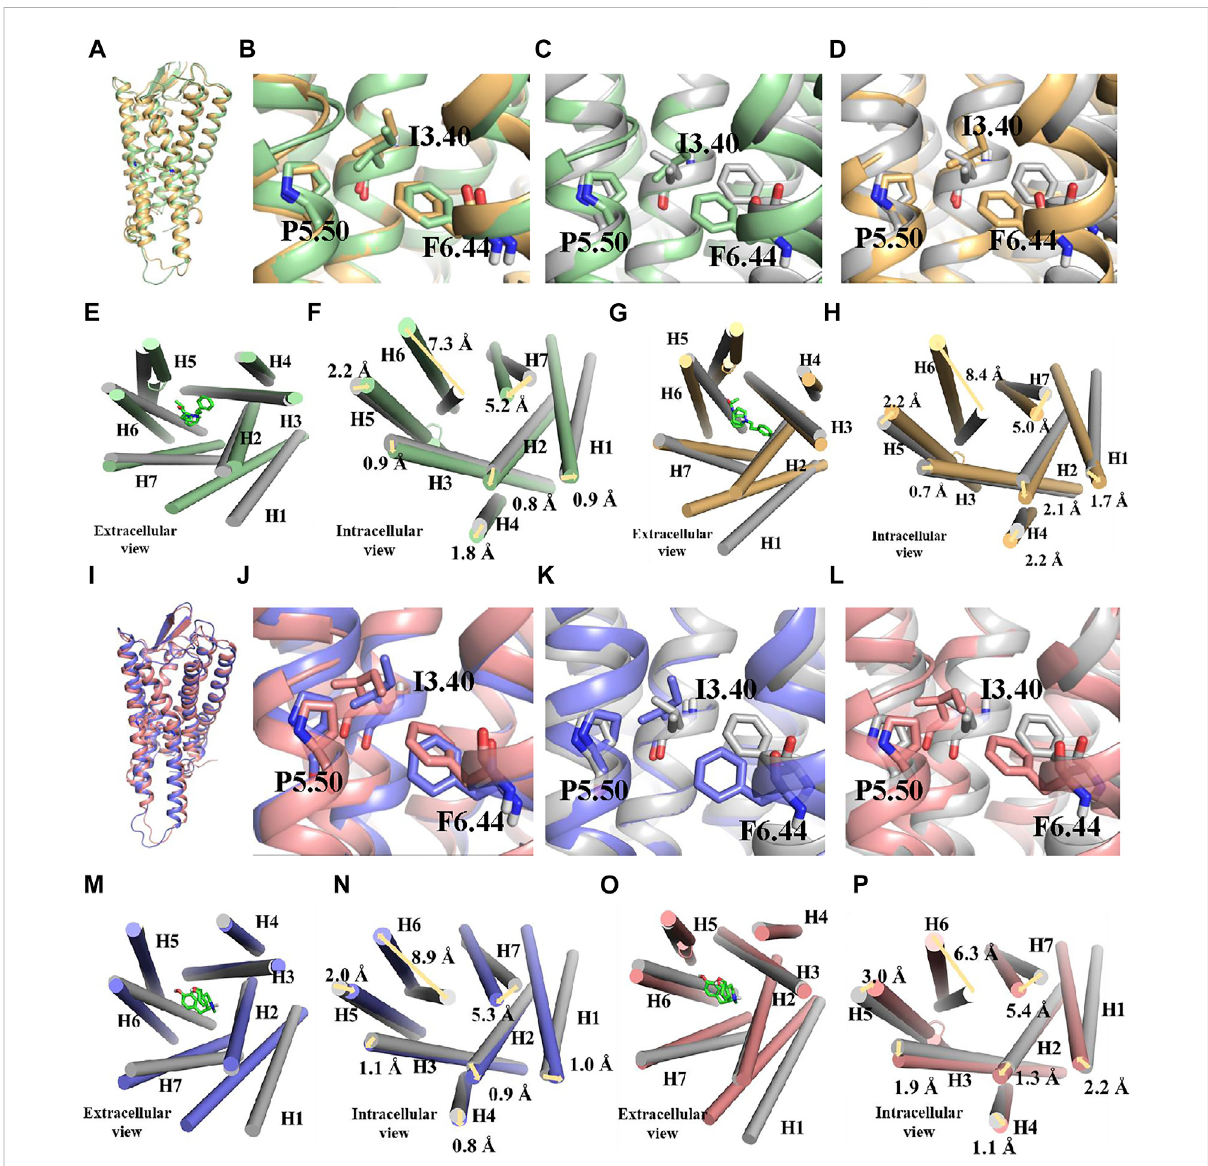
FIGURE 6 Conserved P 5.50 -I 3.40 -F 6.44 triad rearrangement and transmembrane helix change during simulations. (A – H) binding poses and changes of transmembrane helix during the binding process of fentanyl with µ-opioid receptor (MOR). Active wild type (WT), green; active Y7.43A, yellow; apo state, gray; they are shown in ribbon and cylindrical shape in binding pose and transmembrane helix, respectively. Residues are shown in the ball – stickmodel. (I – P) bindingposes andchanges oftransmembranehelix during thebindingprocessofmorphine with MOR.Active WT,blue; active Y7.43A, pink; apo state, gray; they are shown in ribbon and cylindrical shape in binding pose and transmembrane helix, respectively. Residues are shown in the ball – stick